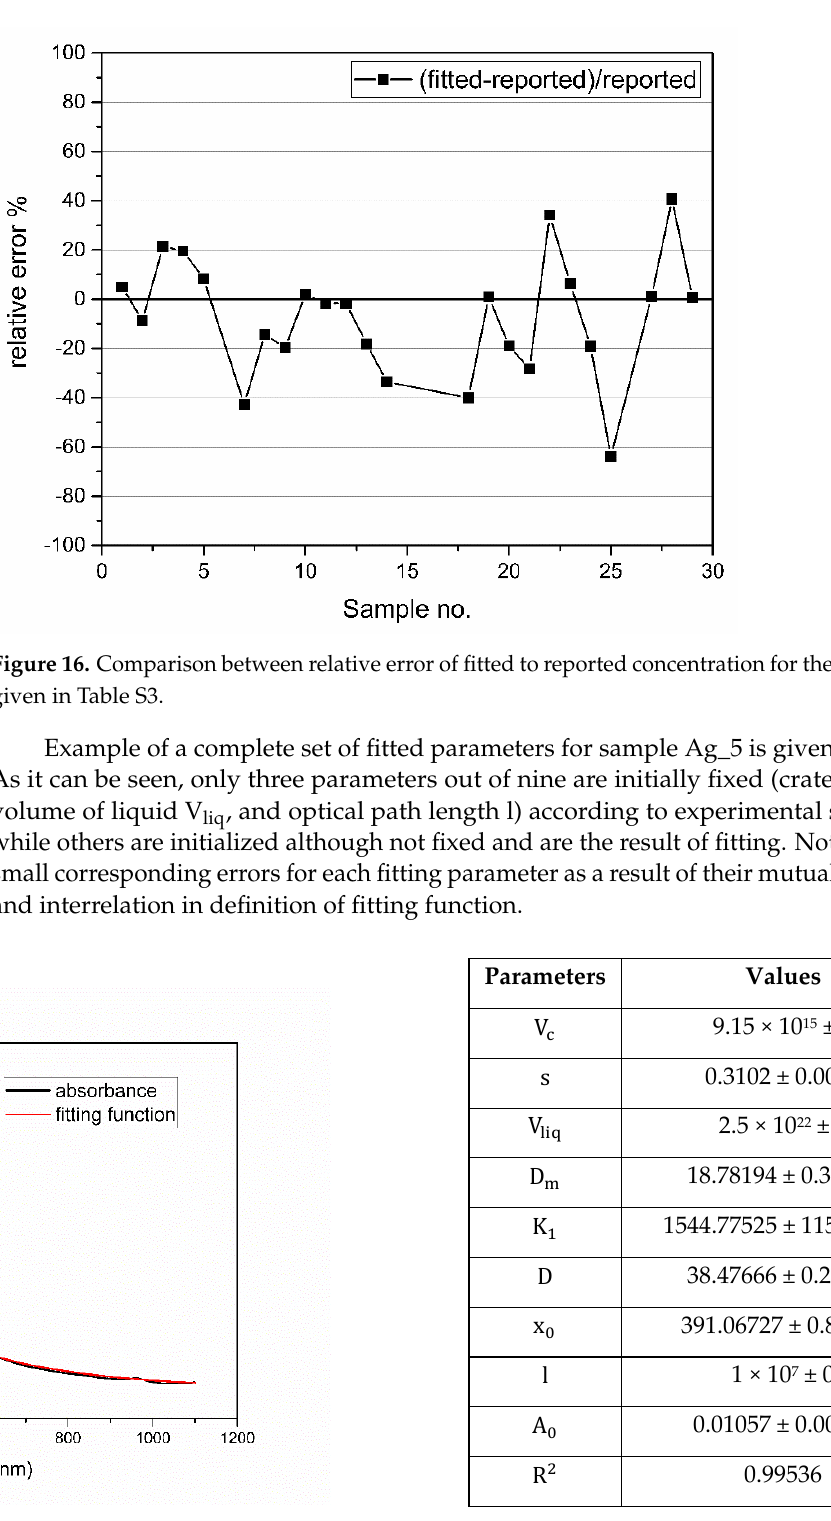
Figure 17. Example of fitting function on a colloidal solution of nanoparticles Ag_5 obtained by the authors with a complete set of fitted parameters. Notice small standard deviations of each parameter and high R 2